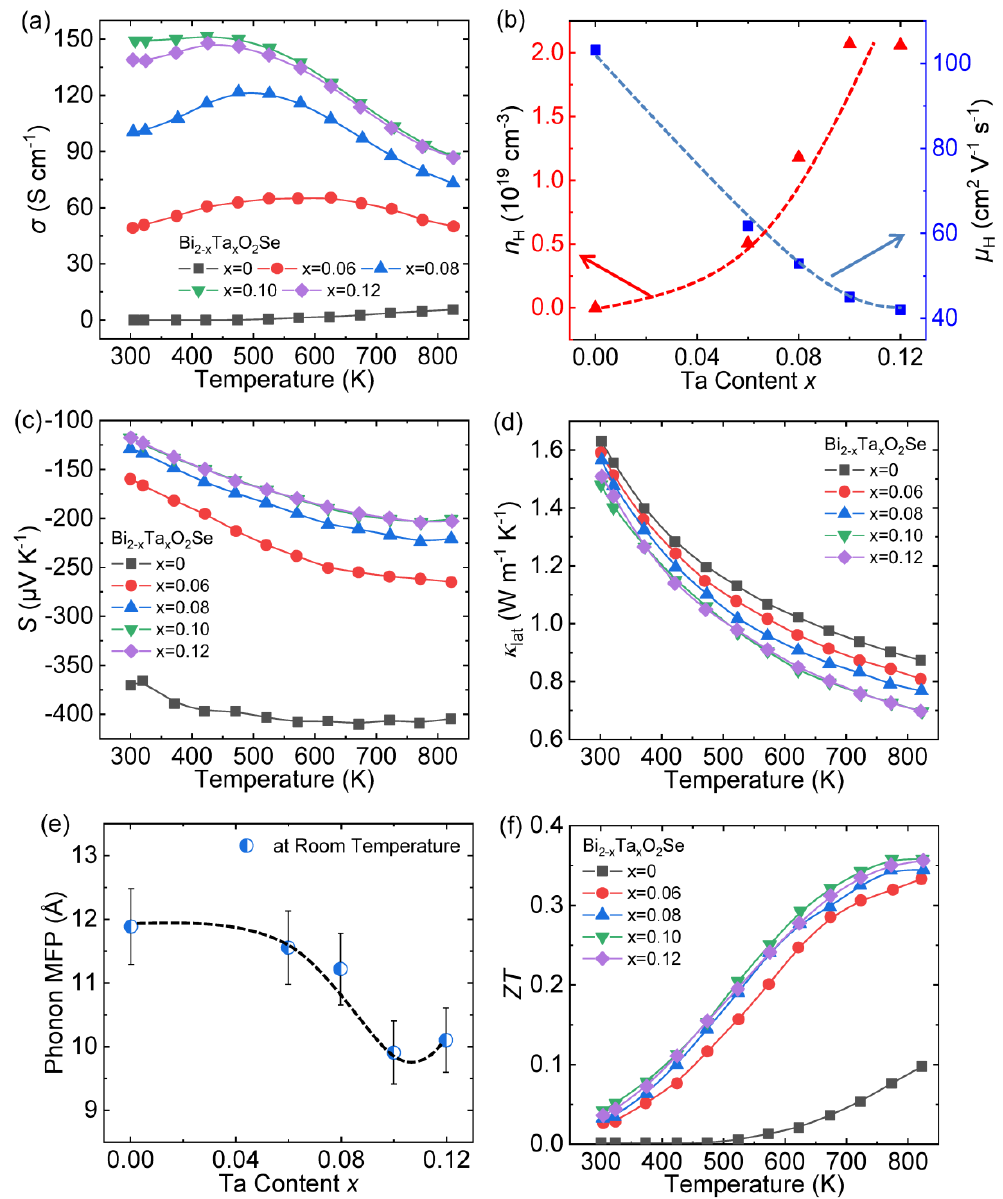
Figure 9. Thermoelectric transport properties of Bi 2-x Ta x O 2 Se ( x = 0–0.12): ( a ) electrical conductivity, ( b ) the carrier concentration and mobility at room temperature, ( c ) Seebeck coefficient, ( d ) lattice thermal conductivity, ( e ) phonon mean free path (MPF, l ph ) at room temperature, and ( f ) ZT . Data shown in ( a – f ) were adopted from Reference [68]. Copyright 2019, WILEY-VCH Verlag GmbH & Co. KGaA, Weinheim.